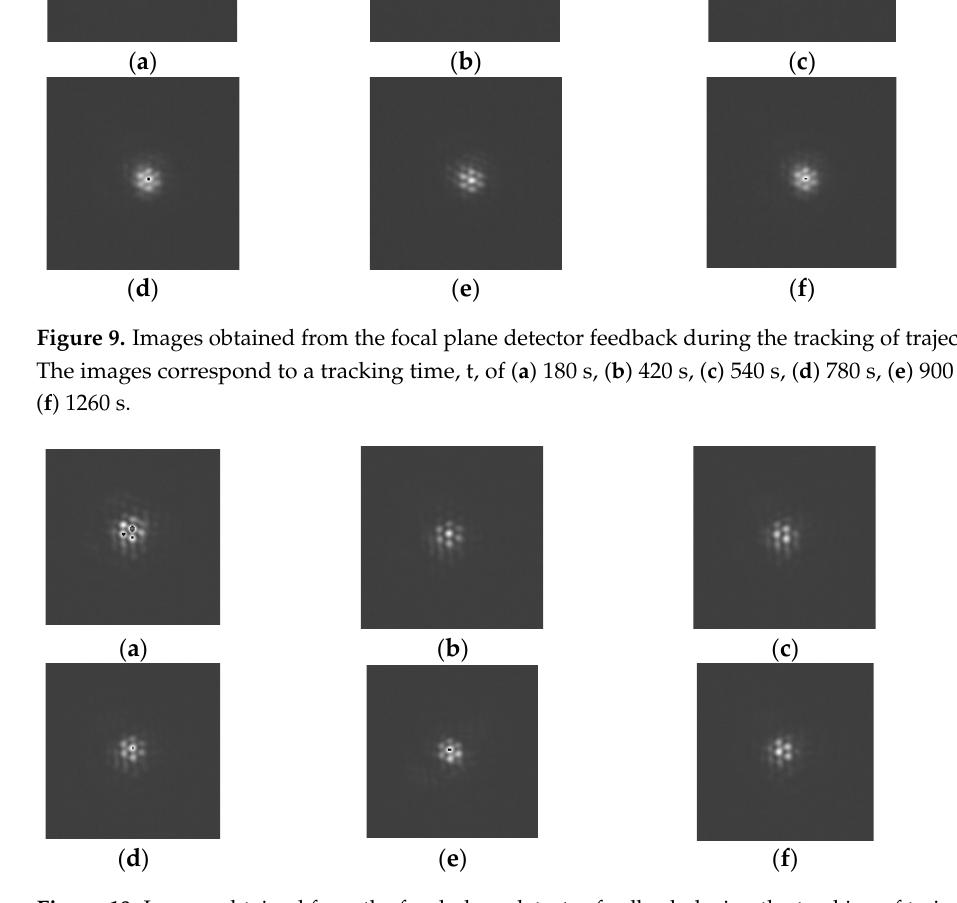
2. The images correspond to a tracking time, t, of ( a ) 50 s, ( b ) 100 s, ( c ) 150 s, ( d ) 200 s, ( e ) 250 s, and ( f ) 300 s.